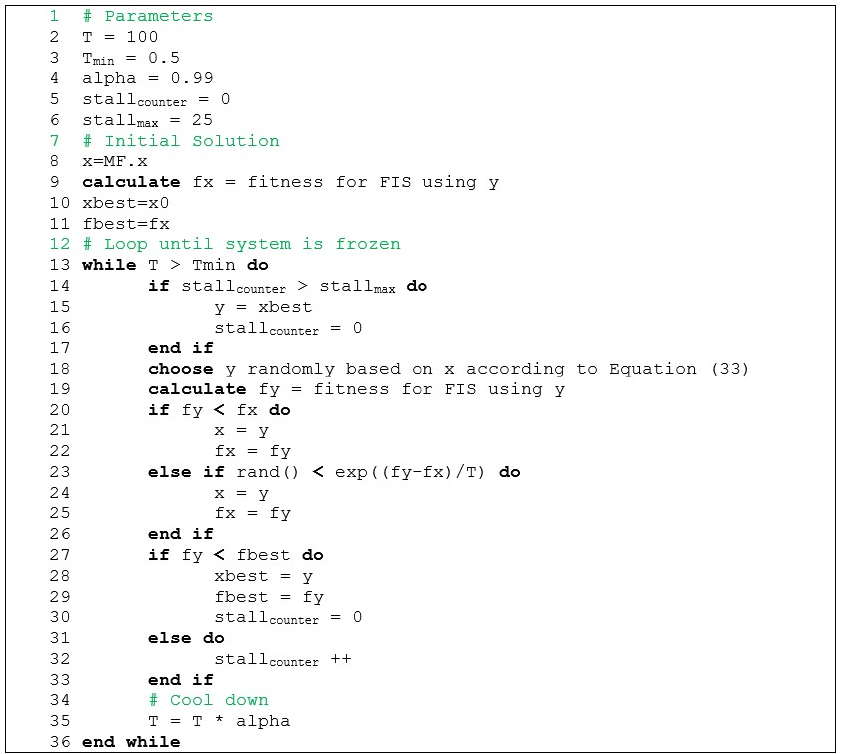
Figure 21. Pseudocode optimisation of fuzzy membership functions (MFs) utilising simulated annealing (SA).